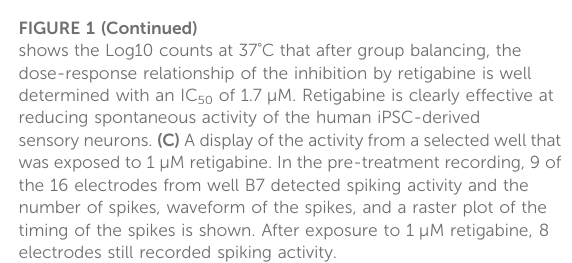
FIGURE 1 Retigabine reduces fi ring of IPSC-SNs in a dose-dependent manner. Spontaneous spiking activity of human iPSC-derived sensory neurons (clone 303) plated into the wells of a 48-well MEA plate. (A) The Log10 count of total spikes observed for a 10 min recording period is displayed with a symbol for each well. The panel illustrates the temperature response of the MEA activity and gives an indication of the well-to-well variability. The data represent the same plate recorded at the indicated temperatures in centigrade. (B) The panel